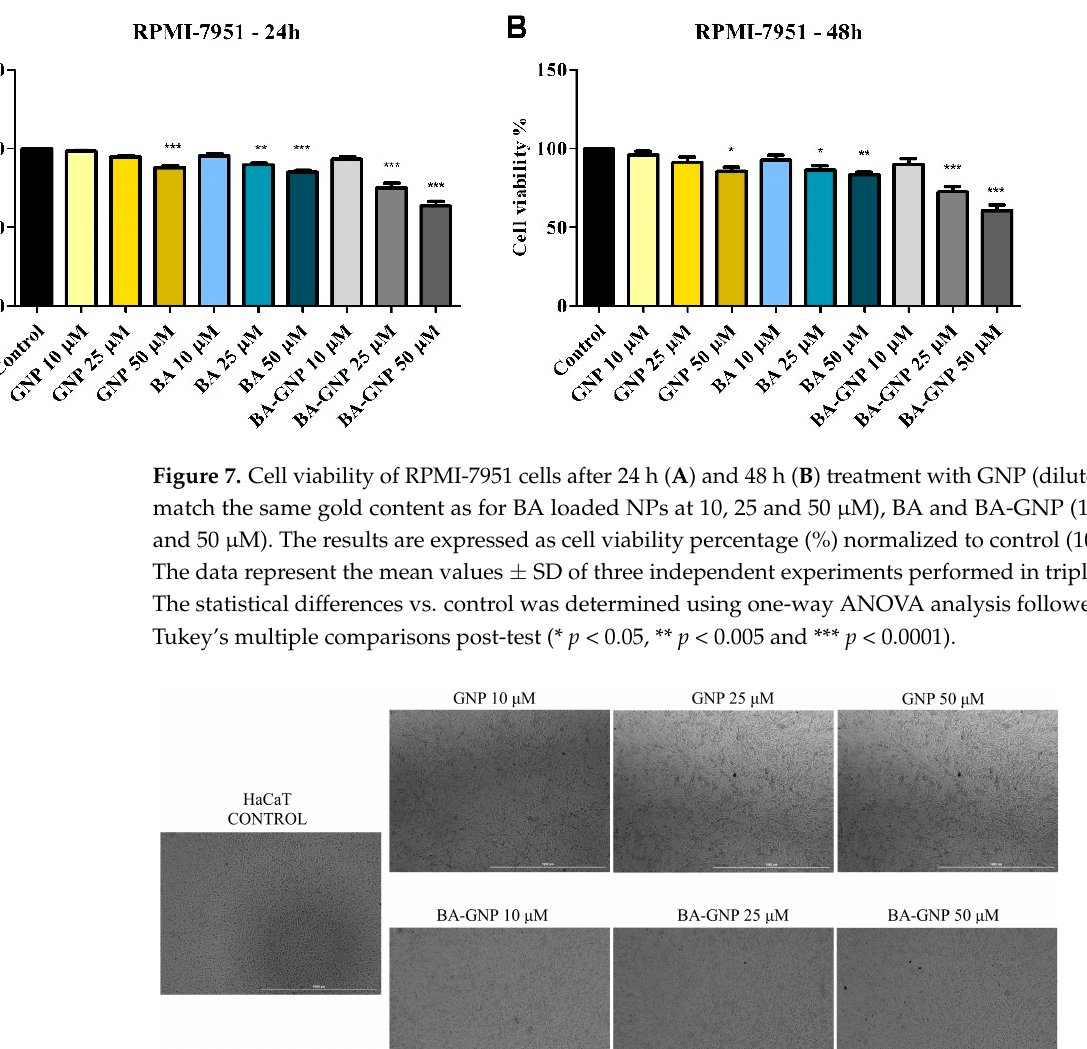
Figure 8. Representative images of the morphological aspect of HaCaT cells after treatment for 24 h with GNP (diluted to match the same gold content as for BA-loaded NPs at 10, 25 and 50 μΜ ) and BA-GNP (10, 25 and 50 μΜ ). The scale bar was 100 μ m.